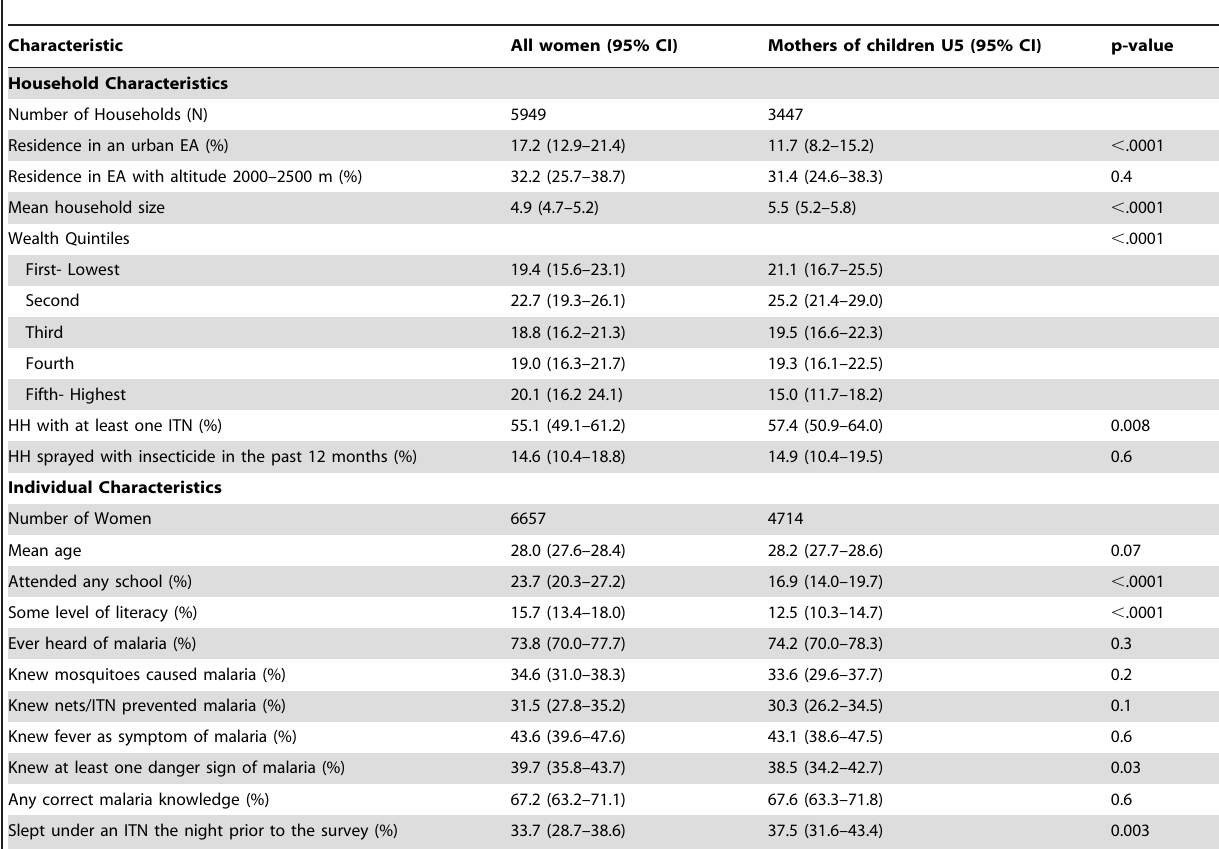
Table 1. Household and individual characteristics for all women and subset of mothers of children under 5 years of age (U5), Ethiopia,